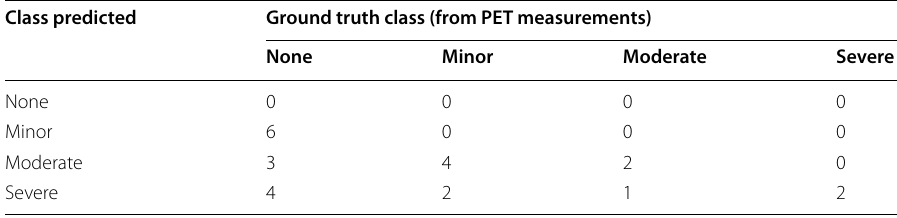
data demonstrated a median difference of 0 MBq and 25th and 75th percentiles of and 0.2 MBq, respectively. Outliers were observed when leaving out comparatively high image-derived extravasation activities or topical detector estimates. For instance, leaving out the highest recorded PET-derived extravasation (